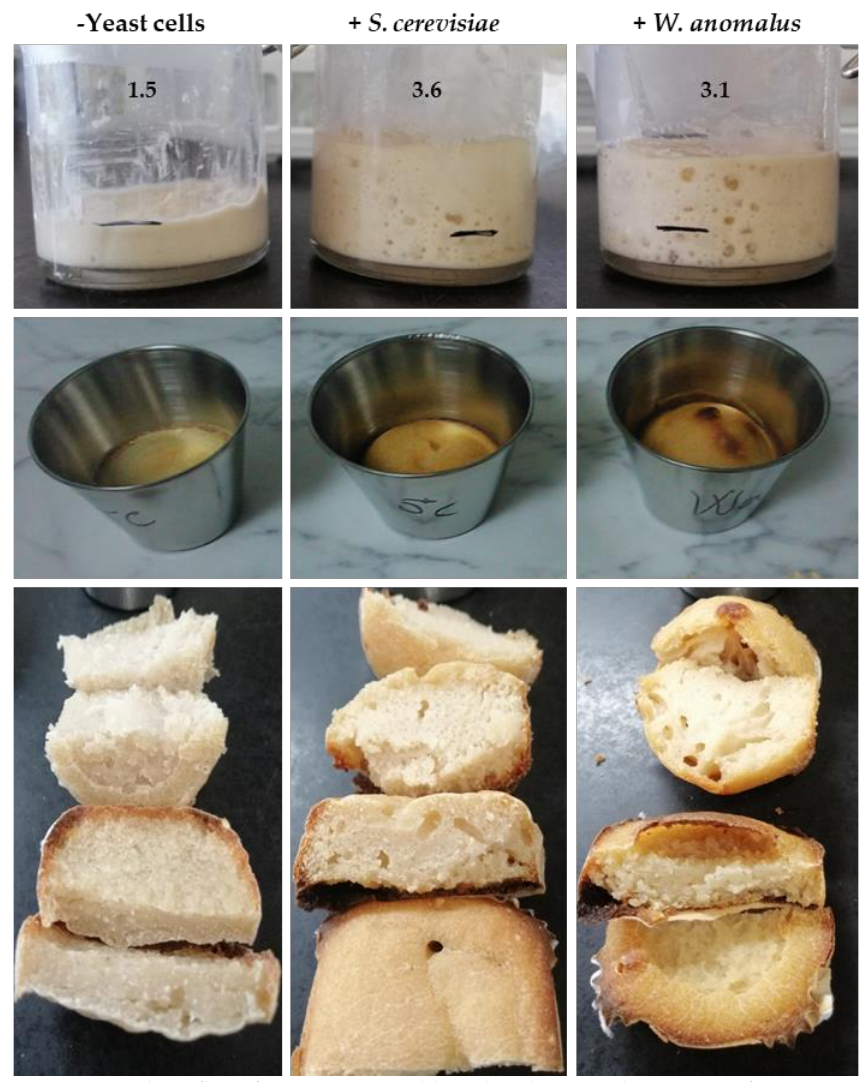
Figure 6. Wheat flour fermentation and bread making. In the top row, fermentation of the wheat flour dough uninoculated ( − yeast cells) and inoculated (+) with the yeast W. anomalus ME1 strain or S. cerevisiae Hércules strain is shown. The number above the dough indicates the height reached, and the black line is the initial position of the dough. The left-hand image was taken at the end of fermentation (24 h) and the other two when the dough reached the maximum rise, the W. anomalus -inoculated dough at 14 h and the S. cerevisiae -inoculated at 10 h. The bread obtained from the fermented dough is shown in the photographs of the middle (after baking) and bottom (after slicing).